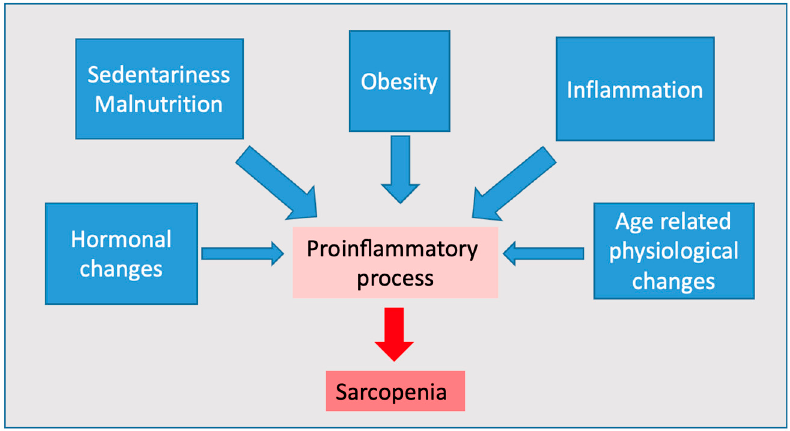
Figure 1. Causes contributing to the onset of